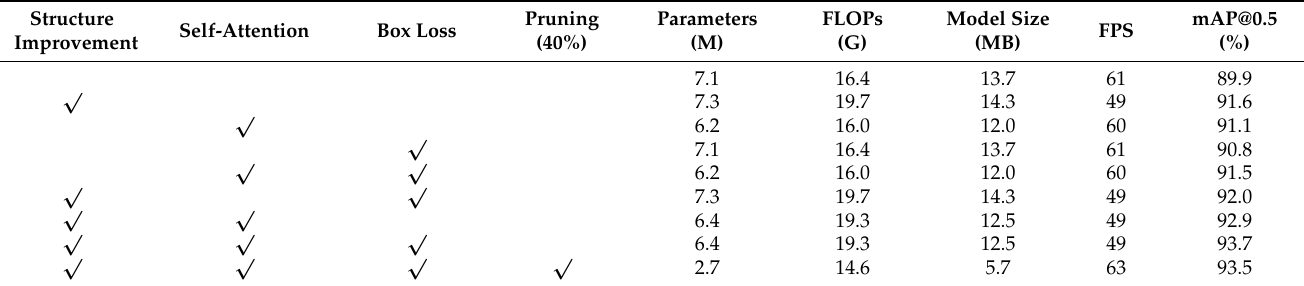
Table 4. Ablation experiments.